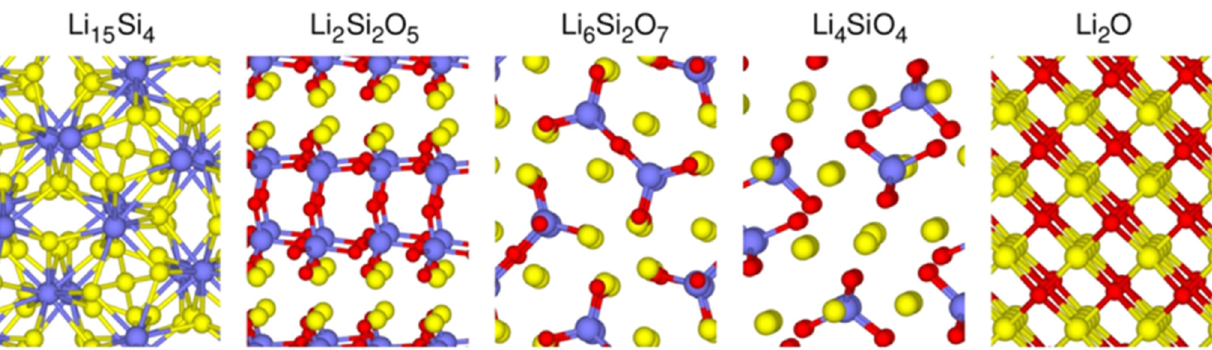
Figure 2. Crystalline structures of Li 15 Si 4 , Li 2 Si 2 O 5 , Li 6 Si 2 O 7 , Li 4 SiO 4 , and Li 2 O. The silicon atom is in blue, the oxygen atom is in red, and the lithium atom is in yellow. The bond length of Si-Si is 2.8Å, and that of Si-O is 2.0Å. To make the structures look succinct, only Si-O bonds are shown in Li 2 Si 2 O 5 , Li 6 Si 2 O 7 , and Li 4 SiO 4 . Reproduced with permission from ref. [13]. Copyright 2015, ACS Publications.